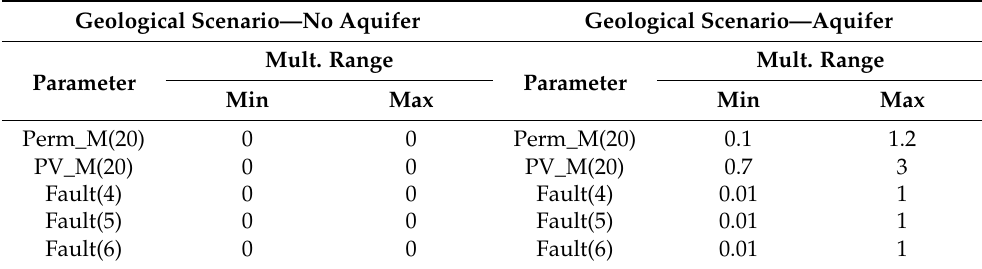
Table 3. The list of parameters used for aquifer scenario modelling.